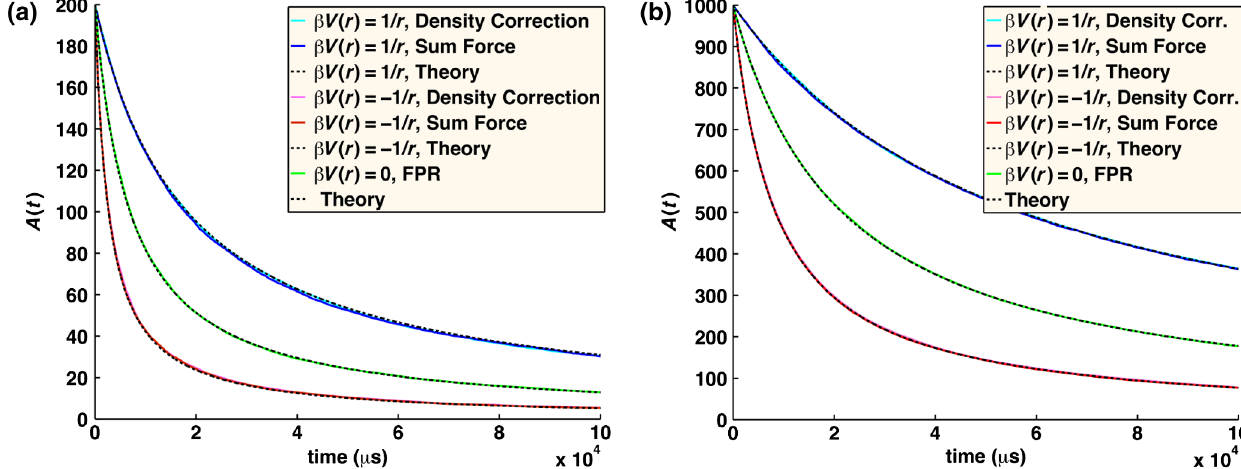
FIG. 13. Irreversible reaction A þ A → 0 with forces between particle pairs. (a) The A particles start at a concentration of 5 . 2 μ M and (b) 1 . 66 μ M. The reaction parameters are the same as in Fig. 7. The relaxation of A ð t Þ is shown for these same reaction parameters in the presence of a repulsive potential (bluish solid curves), no potential (green solid curve), and an attractive potential (reddish solid curves). 17 . 15 , 46.31, The black dashed lines represent the theoretical solution to Eq. (27) with k given by Eq. (31), which has values of k on on ¼ and 119 . 57 nm 3 = μ s in that same order. Both long-range FPR approaches perform equally well at reproducing the association rate of the systems, although in the slightly smaller and more dense system in (a), the simulations trend to slightly faster association with the repulsive potential and slightly slower association with the attractive potential. Each curve is averaged over 100